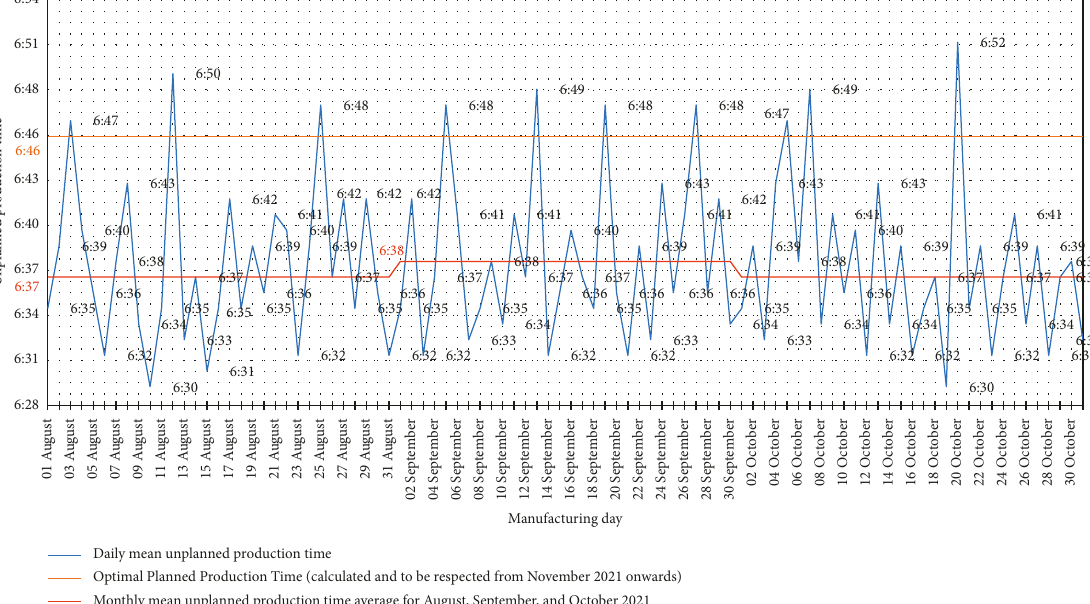
Figure 5: Daily mean unplanned production time and monthly mean unplanned production time averages during August, September, and October